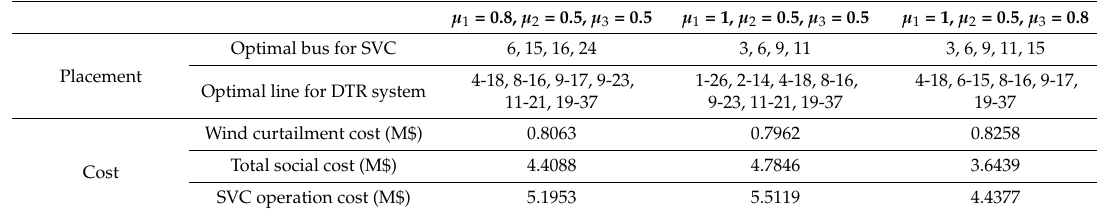
Table 1. Final optimal solutions of different membership function